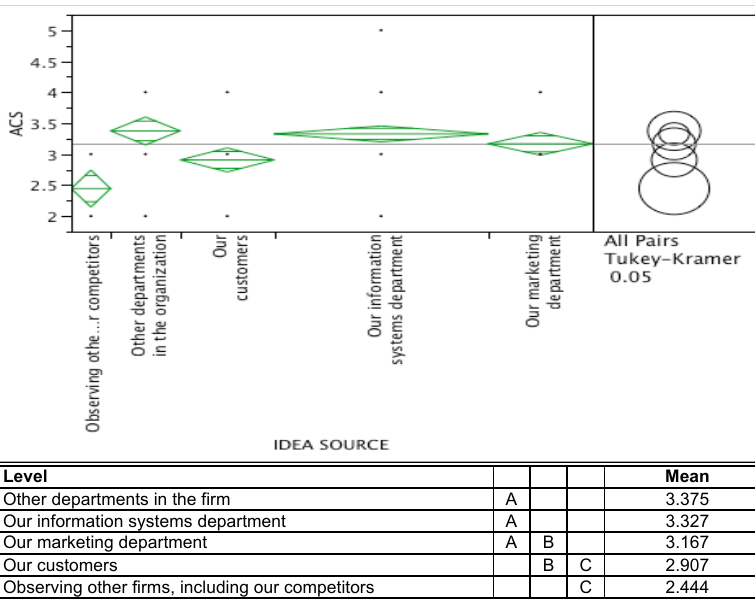
Effects of idea source on perceptions of app cost effectiveness